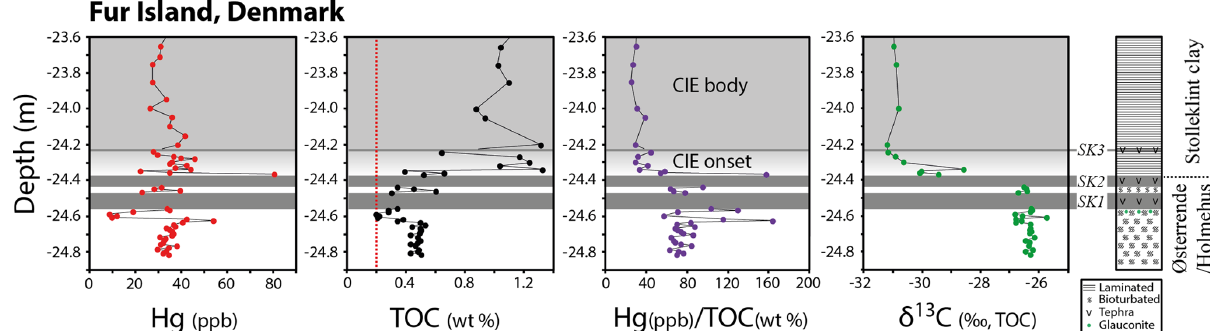
Figure 6. Mercury, TOC, Hg / TOC, and δ 13 C TOC data from an expanded section of the Stolleklint beach section on Fur Island in Denmark, showing the onset of the CIE (see Fig. 5). The colouring scheme is the same as in Fig. 3. The grey shaded area shows the approximate onset and body phases of the CIE. Tephra layers SK1, SK2, and SK3 are marked at their respective depths, along with a stratigraphic log based on the beach section at Stolleklint. The y axis scale is the calculated depth below the top of tephra layer no. − 33 (see the Supplement). The red dashed line in the TOC graph denotes the recommended threshold for TOC concentrations to report Hg / TOC values (Grasby et al., 2016). Samples with TOC values below this threshold were omitted from the Hg / TOC